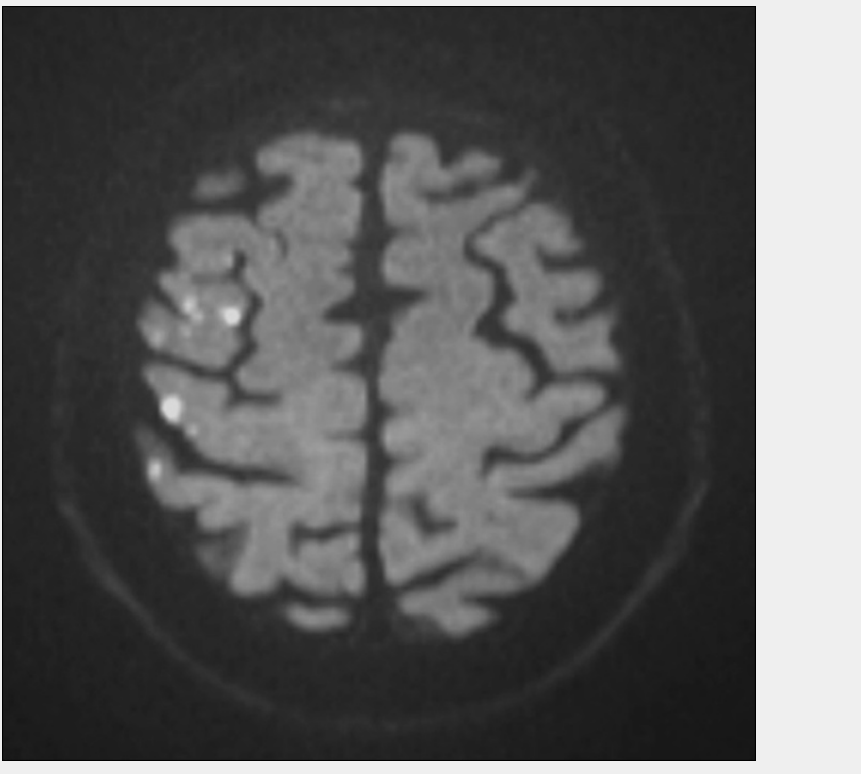
Figure 3 Diffusion weighted MRI of a patient following stenting of the right carotid artery in the MRI substudy of the International Carotid Stenting Study. Multiple hyperintense signals representing acute ischaemic lesions in the territory of the right middle cerebral artery are present. The patient did not experience any symptoms. © Department of Radiology, University Hospital Basel, with kind permission.